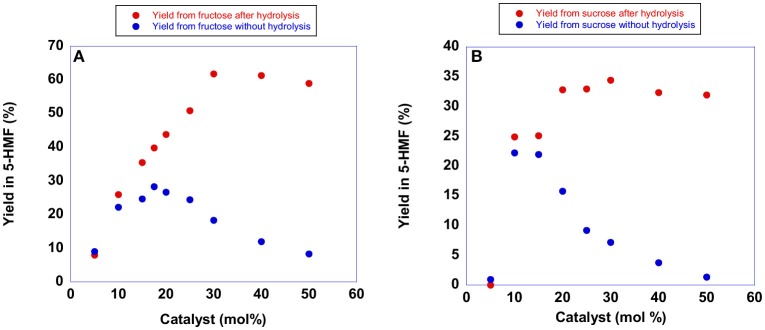
Plots of yields in 5-HMF from (A) fructose obtained at 60°C after 105 min and (B) sucrose obtained at 60°C after 150 min in the presence of increasing amounts of [b2imS][Cl].